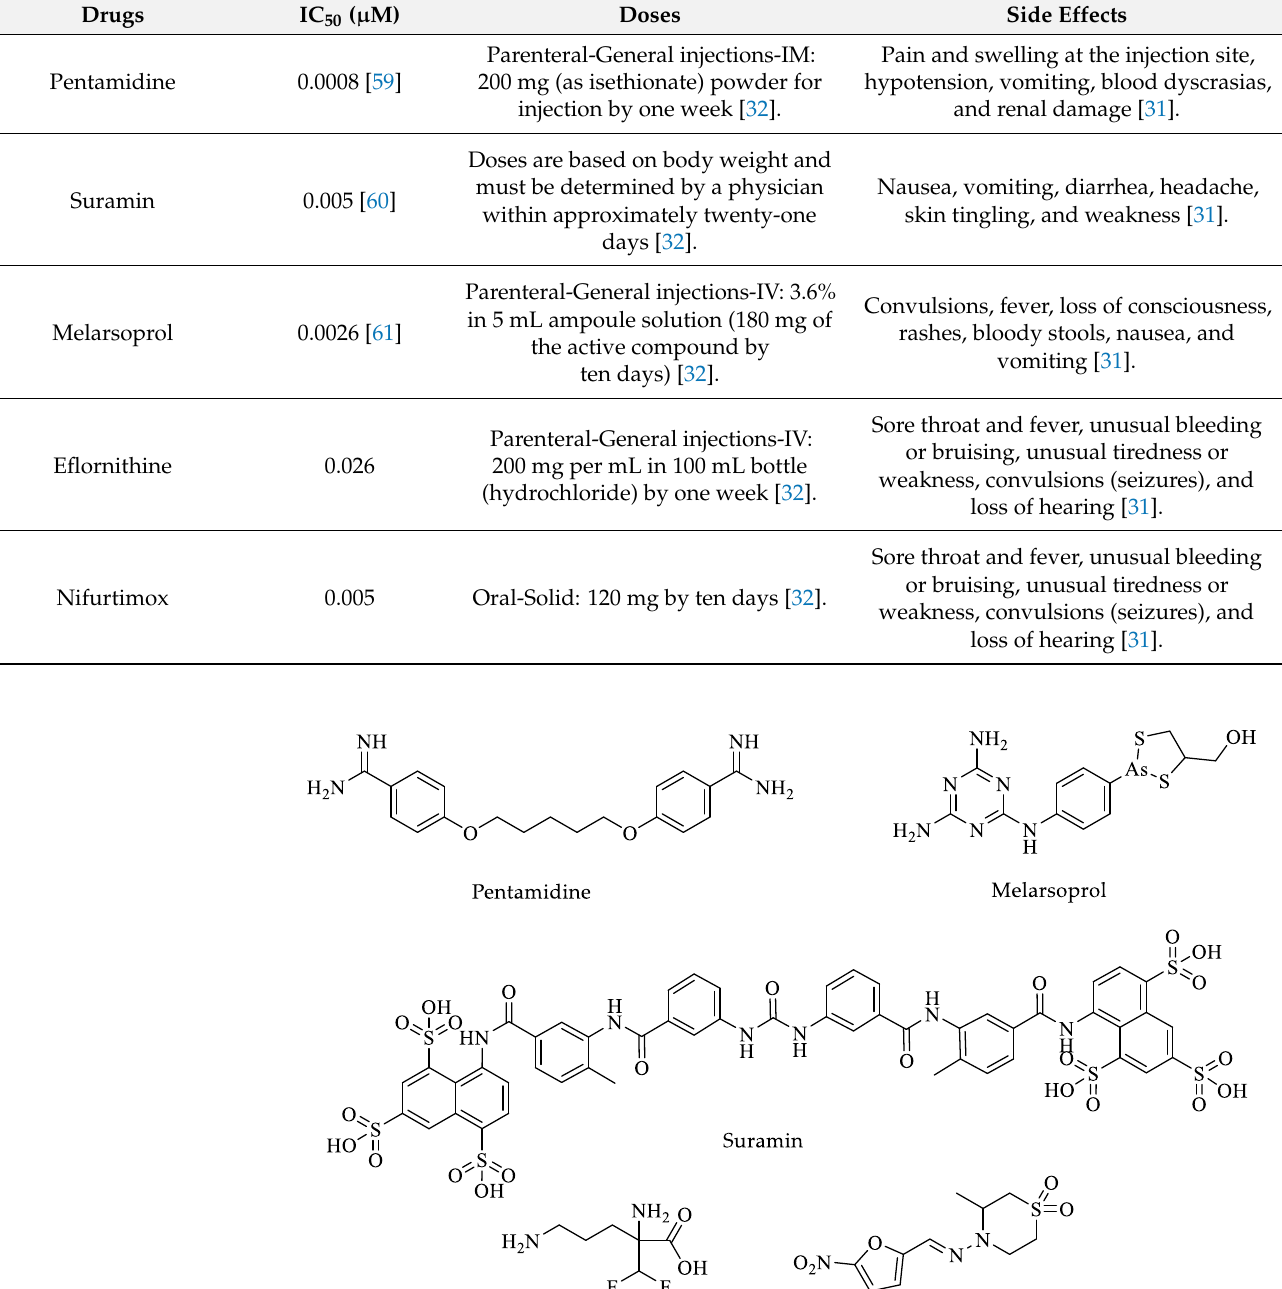
Table 2. Biological activity, dose, and adverse effects of drugs used against T. brucei .